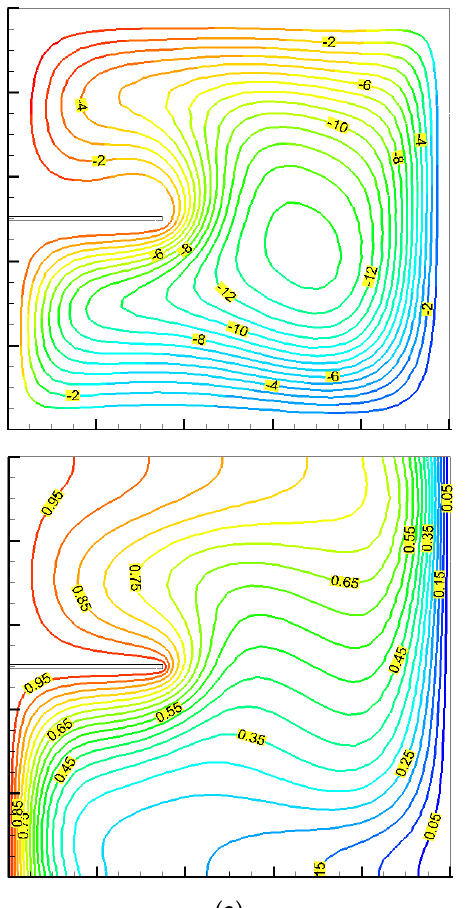
Figure 3. Comparison of the ( a ) present results of isothermal patterns with ( b ) Basak and Chamkha [24] (𝜃) and stream function (  ) for Cu – Water nanofluids with 𝑅𝑎 = 10 5 and 𝜙 = 0.1 .